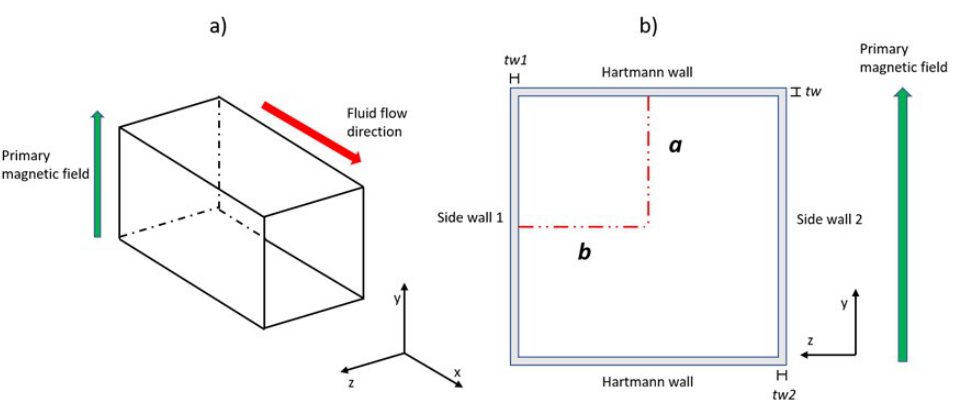
Figure 1. ( a ) Three-dimensional view of a generic hydraulic element (single volume). The green vector is the magnetic field applied and is considered perpendicular with respect to the fluid stream direction (red arrow). ( b ) Cross-sectional view of a hydraulic element. Walls perpendicular to the magnetic field are called Hartmann walls, while those aligned to the magnetic field are referred as Side walls. Characteristic lengths of the component a and b are underlined, and thickness of the walls ( t w ) as well. Table 2. Parameters used to compute Magnetohydrodynamic 2D additional pressure drop factor. Parameter Description Units Primary magnetic field B (defined in Magnetic field, always considered perpendicu- lar to the stream direction. Component half-length along magnetic field direction. Component half-length perpendicular to mag- netic field